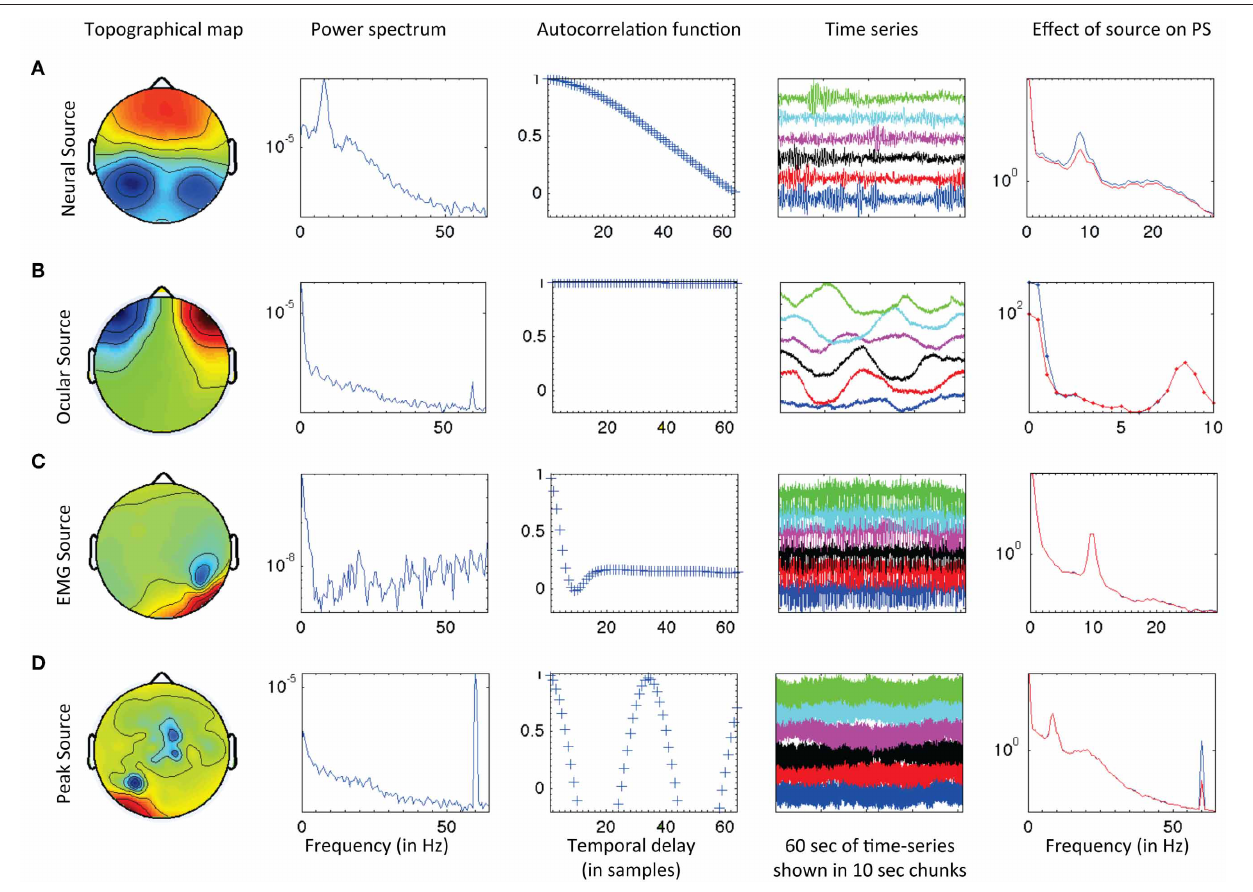
FIGURE 1 | Examples of (A) neural, (B) ocular, (C) EMG, and (D) peak sources retrieved through SOBI and classified using SMART. SMART extracts several features from the data for initial classification of the sources and generates an html report for quick and efficient quality control. See text for